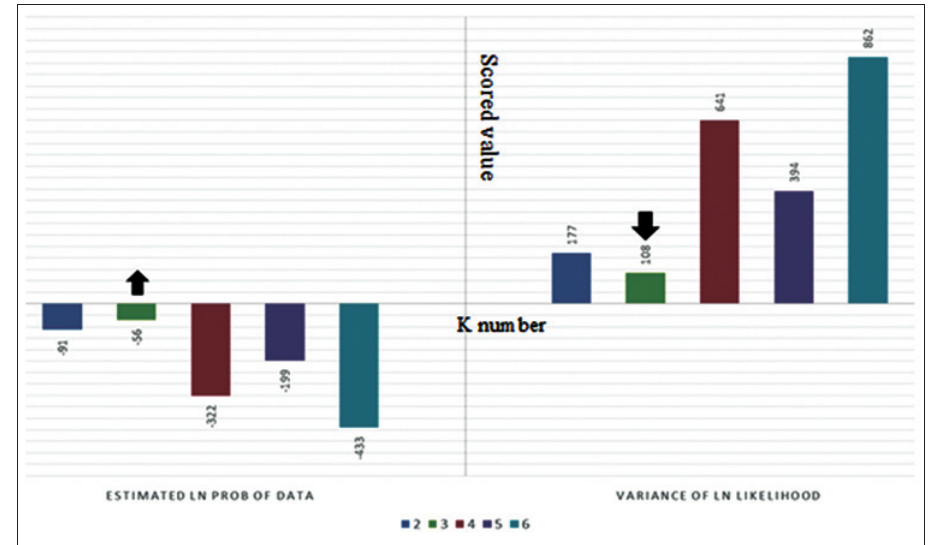
Figure-3: Graphical plotting of structure software output scores based on amplified fragment length polymorphism loci . Estimated ln probability (LnP) and variance of ln likelihood (VLn) for K=[2-6], are shown. K=3 shows the lowest VLn and highest